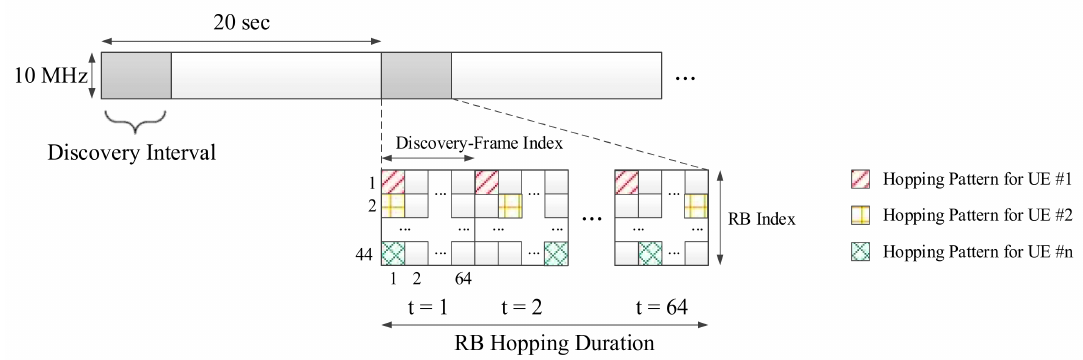
Figure 1. Timing diagram of repetitive LTE uplink frames including peer discovery time